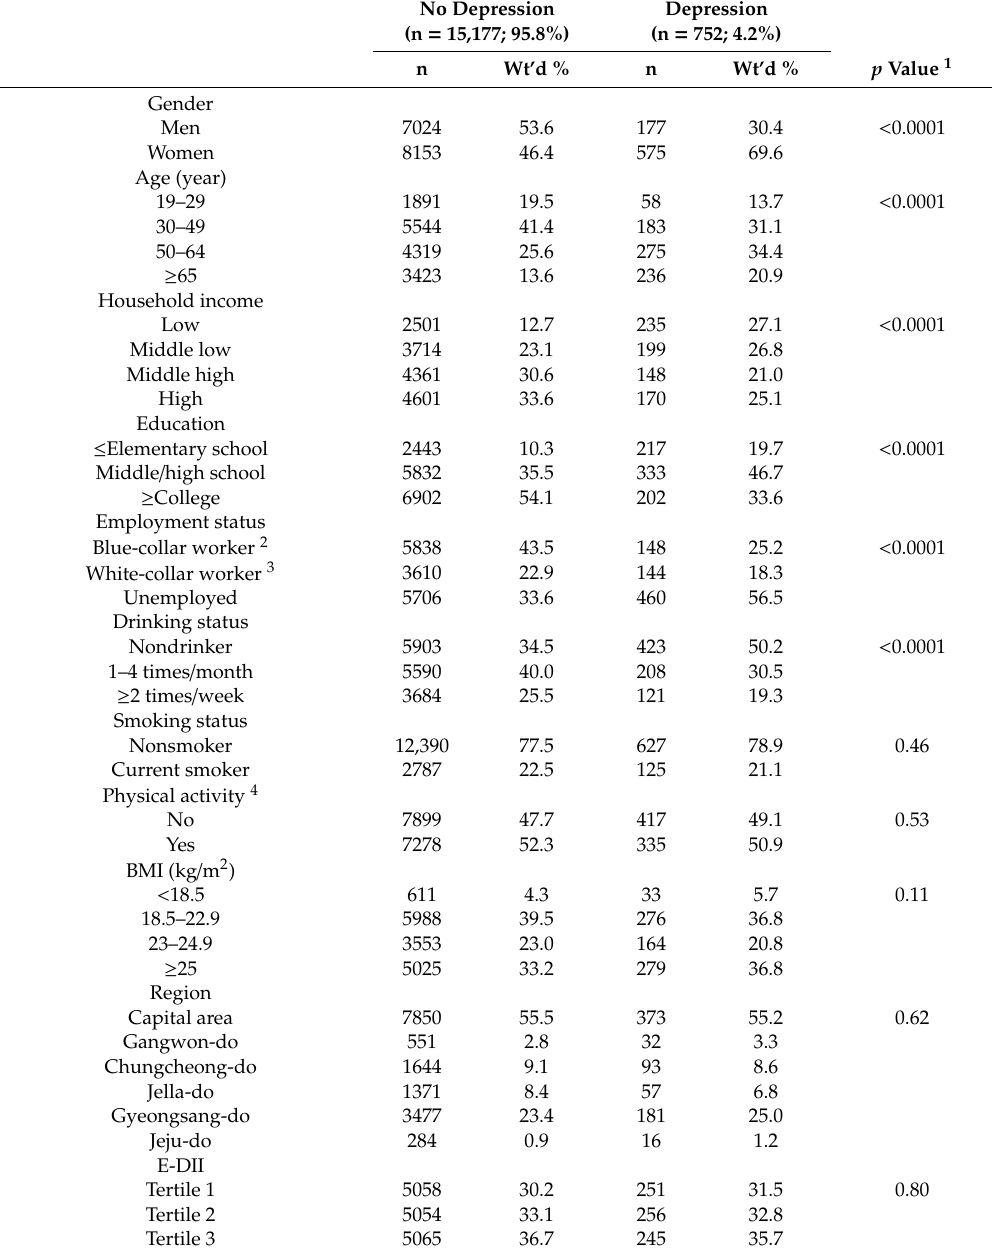
Table 2. Distributions of sociodemographic, lifestyle factor, and energy-adjusted dietary inflammatory index (E-DII) scores based on the status of